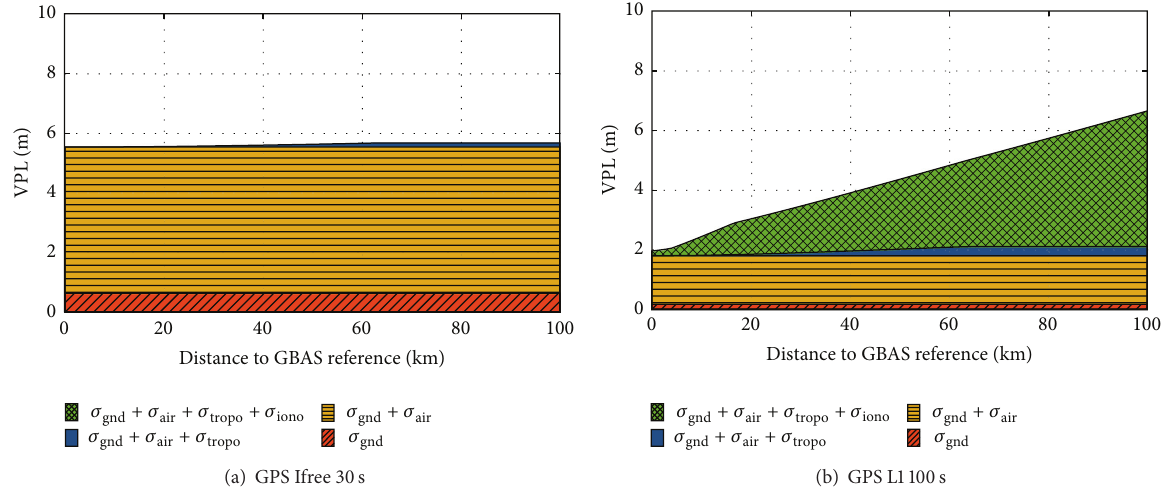
Figure 13: H0 protection level contributions of different 𝜎 -terms over distance to the GBAS station for a hypothetical MLA antenna.